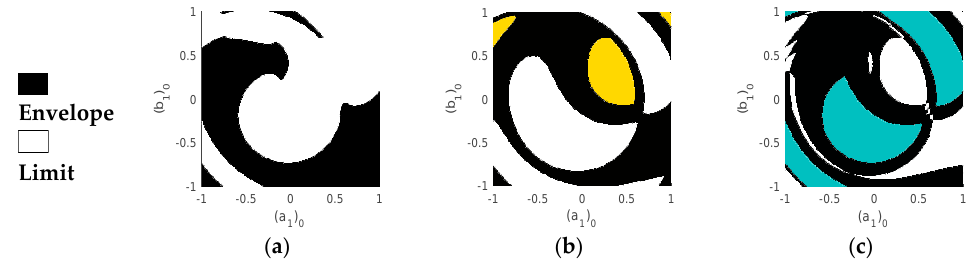
Figure 9. Envelopes of the attractors of ( a ) SM-RB, ( b ) SM-NRB and ( c ) DM of the modal intensity of the first pendulum response, in the Nyquist plane (((cid:1853) (cid:2869) ) (cid:2868) ,((cid:1854) (cid:2869) ) (cid:2868) ) for (cid:2026) = −1 and amplitude (cid:3627)(cid:1827)(cid:4634) (cid:2869) (cid:3627) ((cid:1853) (cid:2870) ) (cid:2868) = ((cid:1854) (cid:2870) ) (cid:2868) = 0.25 , computed using the gPCE method for (cid:2012) (cid:3039) = 2% .